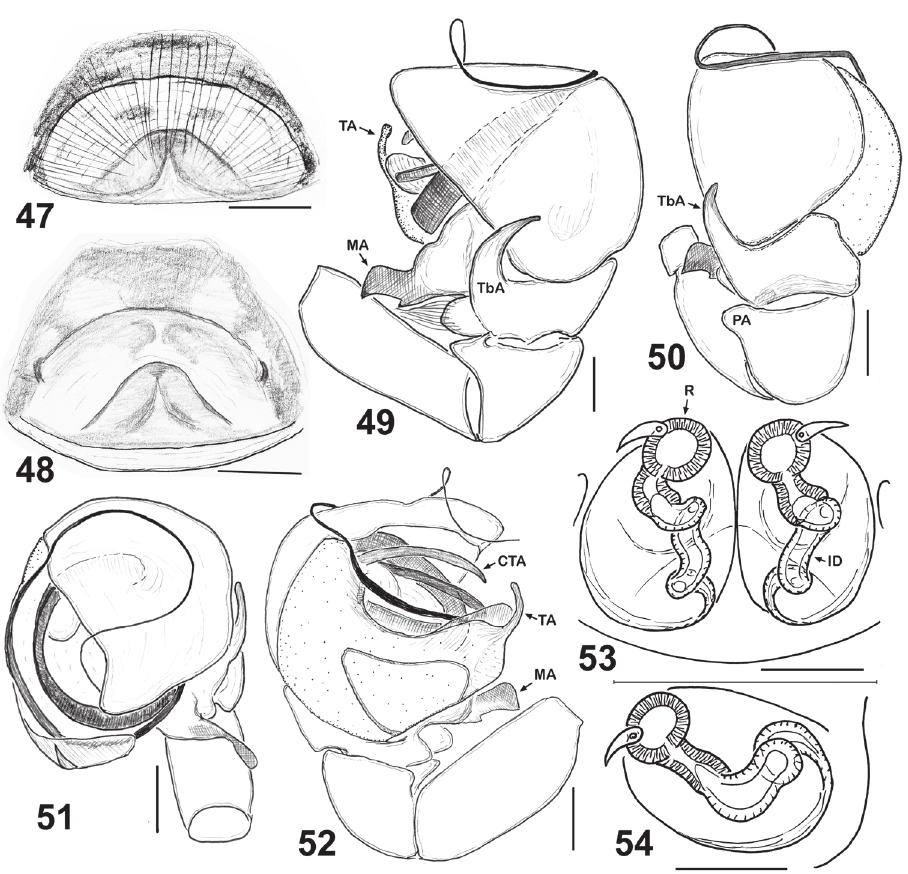
Figures 47–54. Copulatory organs of Eupoa lehtineni sp. n. 47–48 epigyne, ventral view 49 male palp, retrolateral view 50 ditto, dorsal view 51 ditto, apical view 52 ditto, median view 53–54 vulva, dorsal view. Abbreviations as explained in ‘Material and methods’. Specimens: 49–53 – India; 47–48 , 54 – Viet- Nam. Scale bars: 50 μm ( 27, 29 ), 0.1 mm ( 25–26 , 28 , 30–32